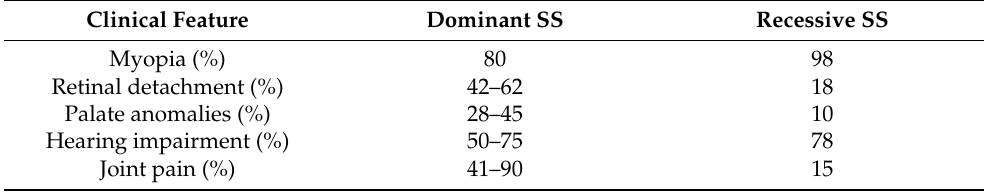
Table 6. Comparison of prevalence of clinical features of dominant vs. recessive